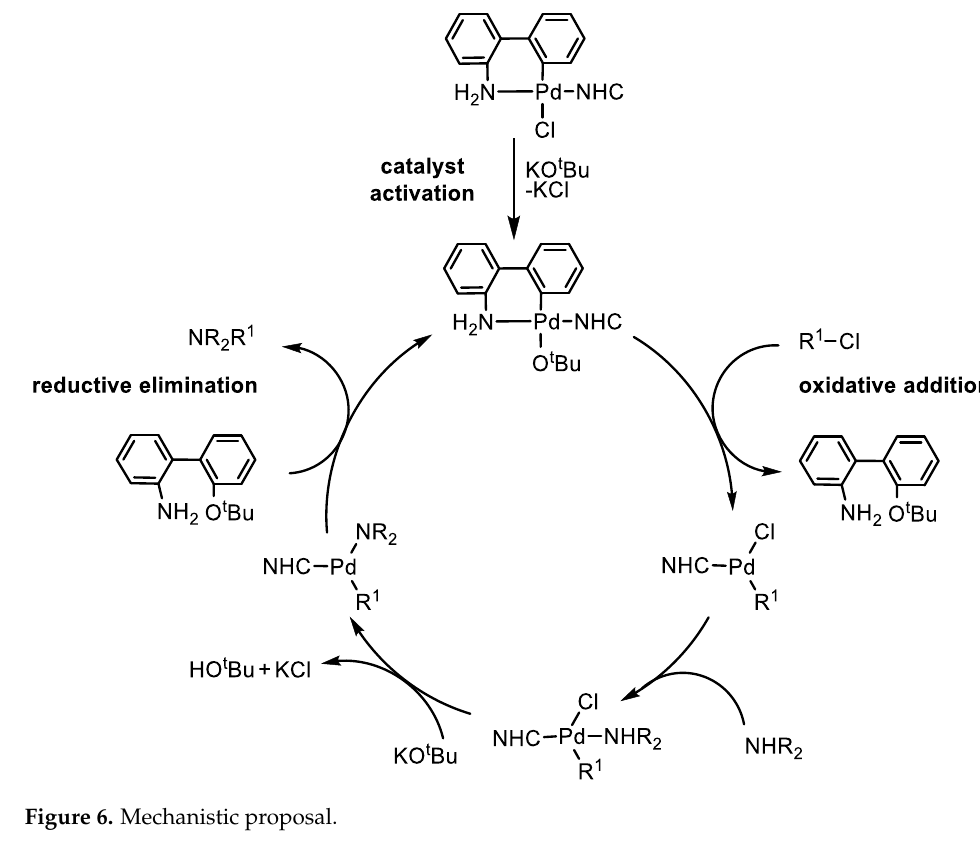
Figure 6. Mechanistic proposal .